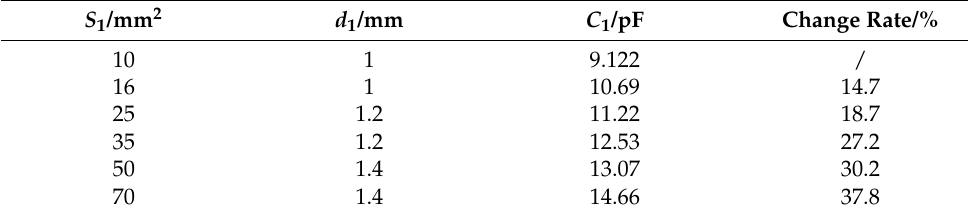
Figure 2. Finite element simulation model and parameters. Table 1. Simulation Values of Capacitance under Different Specifications of Lines.